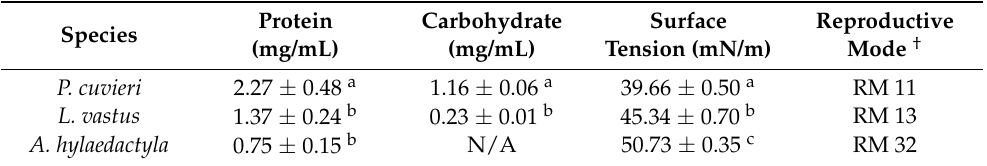
Table 1. Concentration of proteins and carbohydrates and surface tension activity in foam nests of neotropical frogs that have different modes of